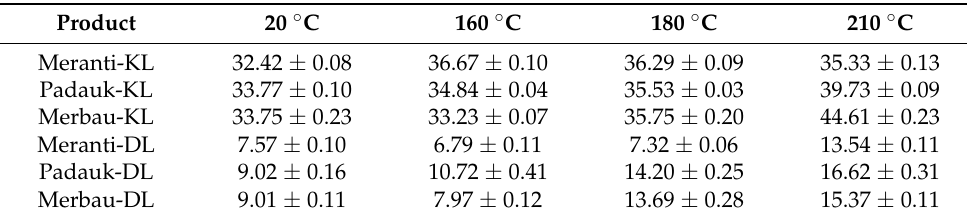
Table 1. Klason (KL) and dioxane lignin (DL) yields from untreated and thermally treated meranti, padauk, and merbau (mean ± SD, %